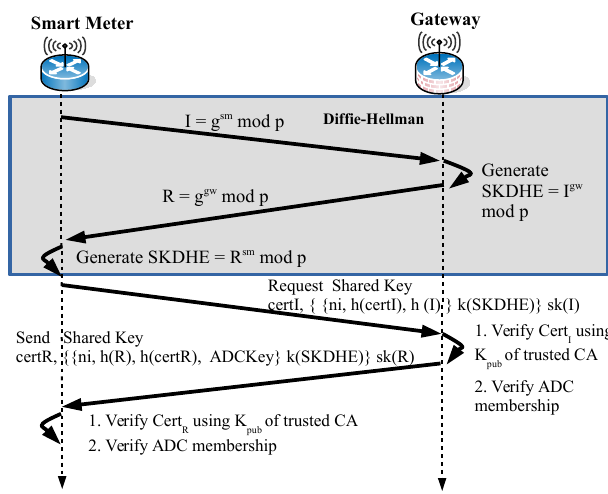
Figure 5. Dataflow of proposed key distribution algorithm. Smart meter act as Initiator and Gateway acts as a Responder. All messages sent are signed by the private key of the sender node. Thus the Initiator (SM) and the responder (gateway) are correctly authenticated one to each